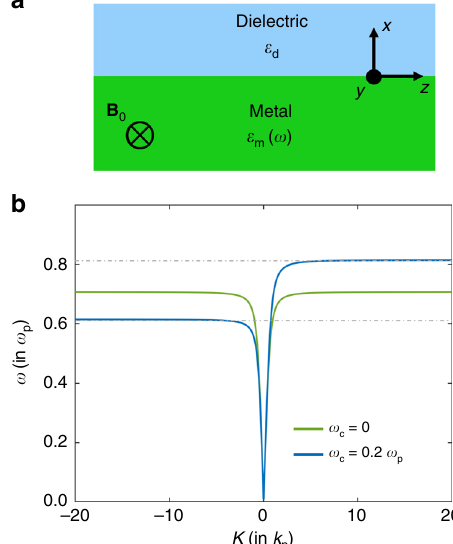
Fig. 1 Surface-plasmon-polariton dispersion relation in the local Drude model. a An interface between a dielectric and a metal described by the Drude model. b Dispersion relation of surface-plasmon-polariton propagation at the interface in the absence (green curve) and in the presence (blue curve) of an external magnetic fi eld B 0 as indicated in a . K is the wavevector component parallel to the interface, k p = ω p /c , and ω c = eB ∕ m is the cyclotron 0